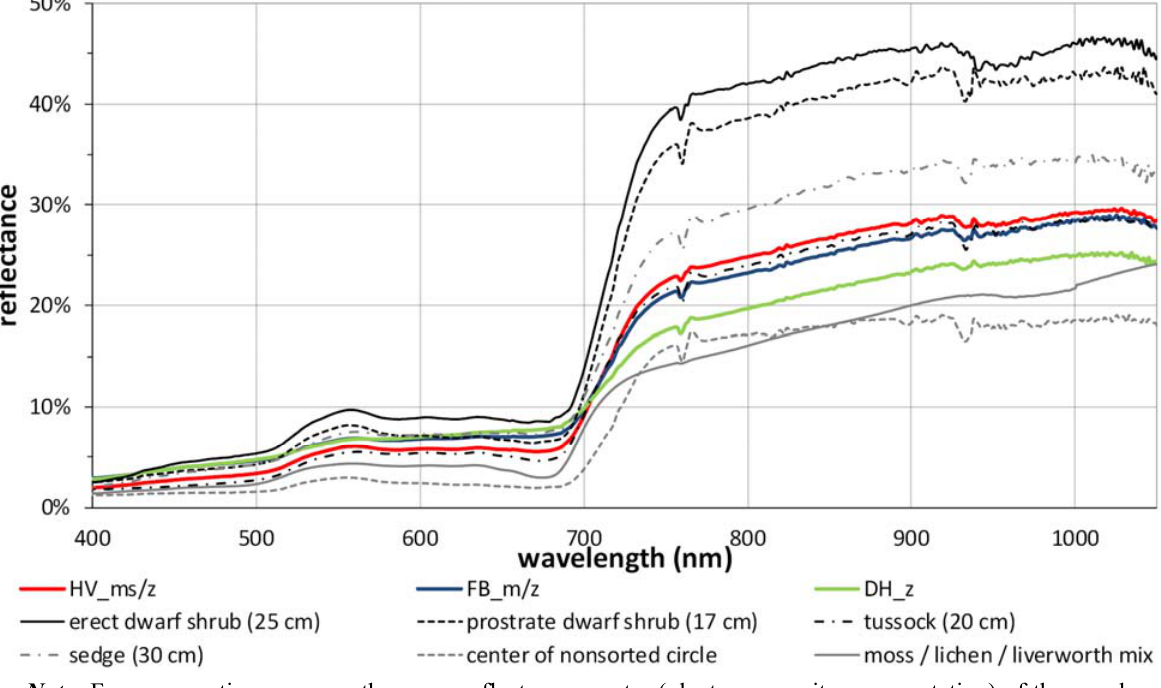
Figure 13. Reflectance spectra of the main plant functional types forming the plant communities of the Low Arctic portion of the